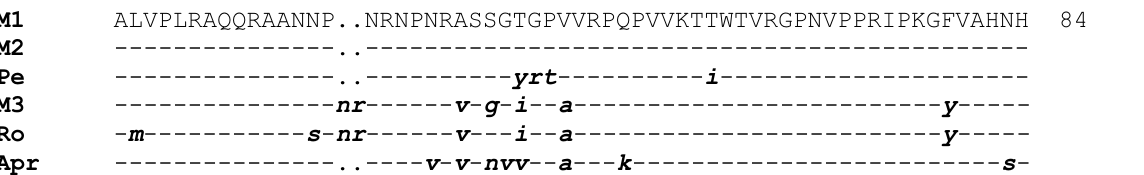
Fig. 4. Amino acid alignment. Multiple alignment of the putative coat protein sequences of the Prunus necrotic ringspot virus isolates M1, M2, M3, Pe, Ro and Apr translated from the nucleotide sequences shown in Fig. 3.